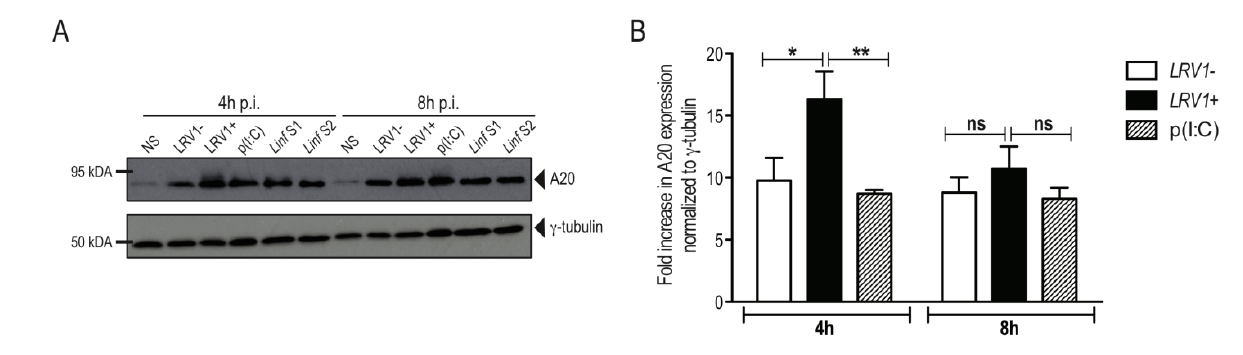
FIGURE 5: L. guyanensis and L. infantum infection induce the up-regulation of the inflammasome inhibitory factor, A20. BMDMs from C57BL/6 WT mice were infected with LgyLRV1+, LgyLRV1- , Linf S1 or Linf S2 parasites or stimulated with poly(I:C) (p(I:C)) as a positive control for TLR3 activation. (A) At 4 or 8 hours after infection, cells were collected, proteins were extracted from cell lysates and were blotted for A20 and γ-tubulin. (B) Quantification of protein expression of LgyLRV1+ or LgyLRV1- infected or poly(I:C) treated macrophages. The graph is representative of four independent experiments, and shown as mean ± SD. Two-way ANOVA was used to calculate significance. *p < 0.05; **p < 0.01; ns: